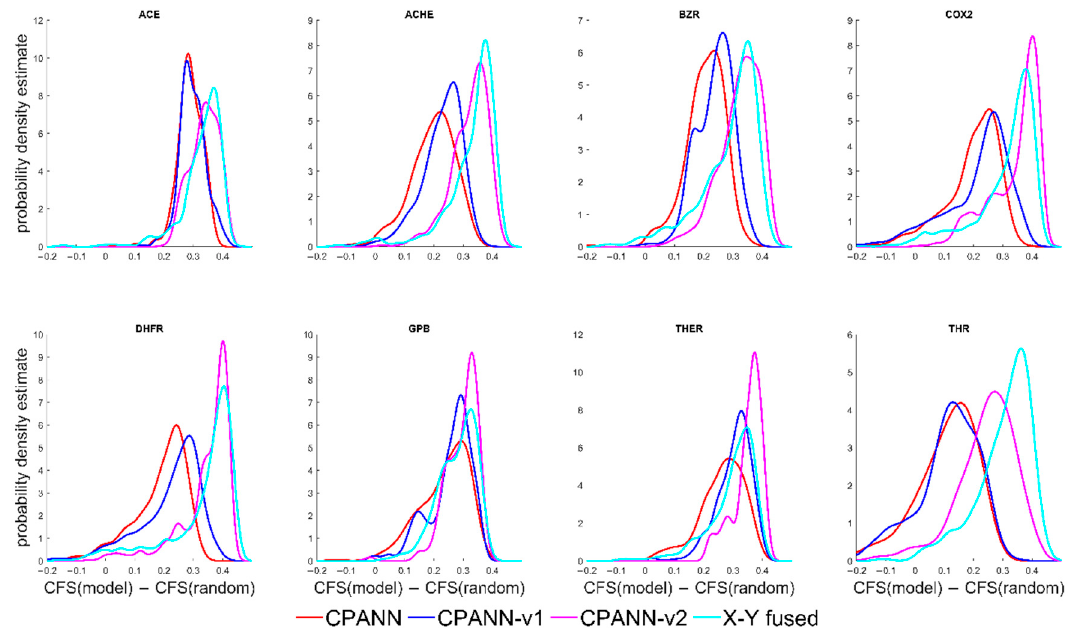
Figure 3. Probability density estimates of differences CFS(model)–CFS(random) obtained for models developed using the additional sets.